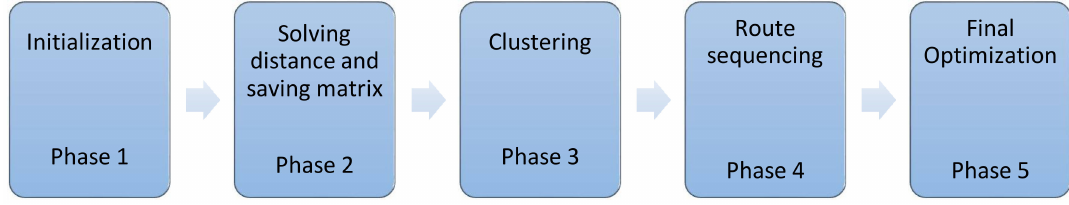
Figure 1. The phases of the proposed